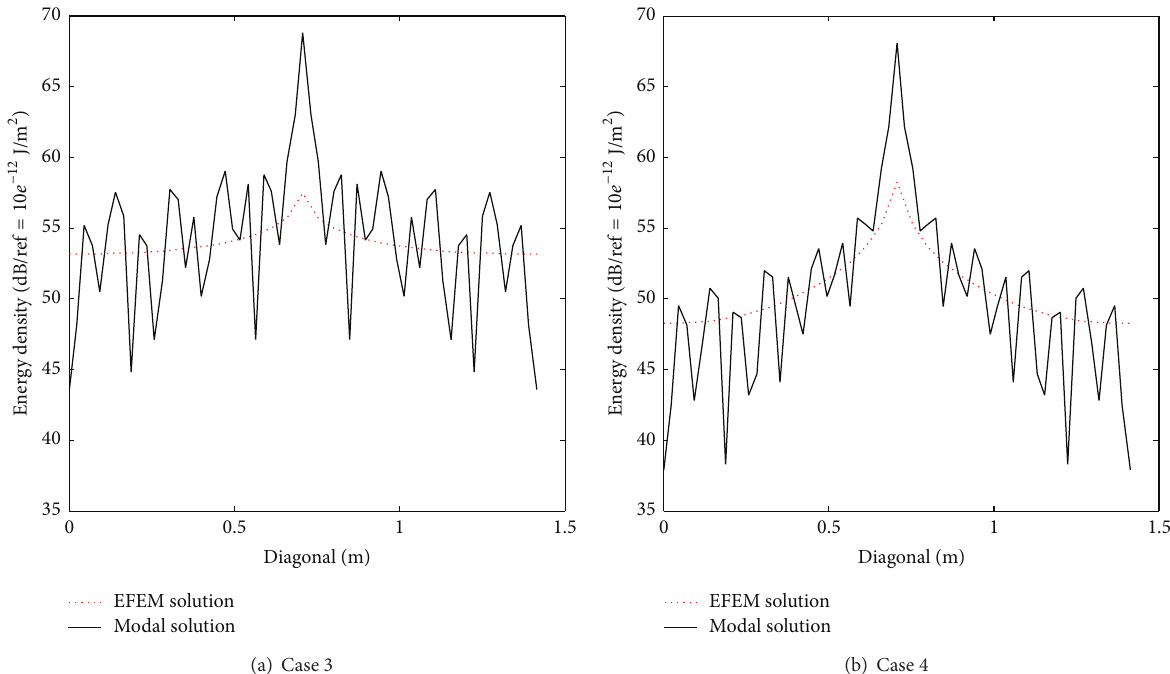
Figure 9: The energy density distribution comparisons between the two methods along the line 𝑦 = 𝑥 in case 3 and case 4.